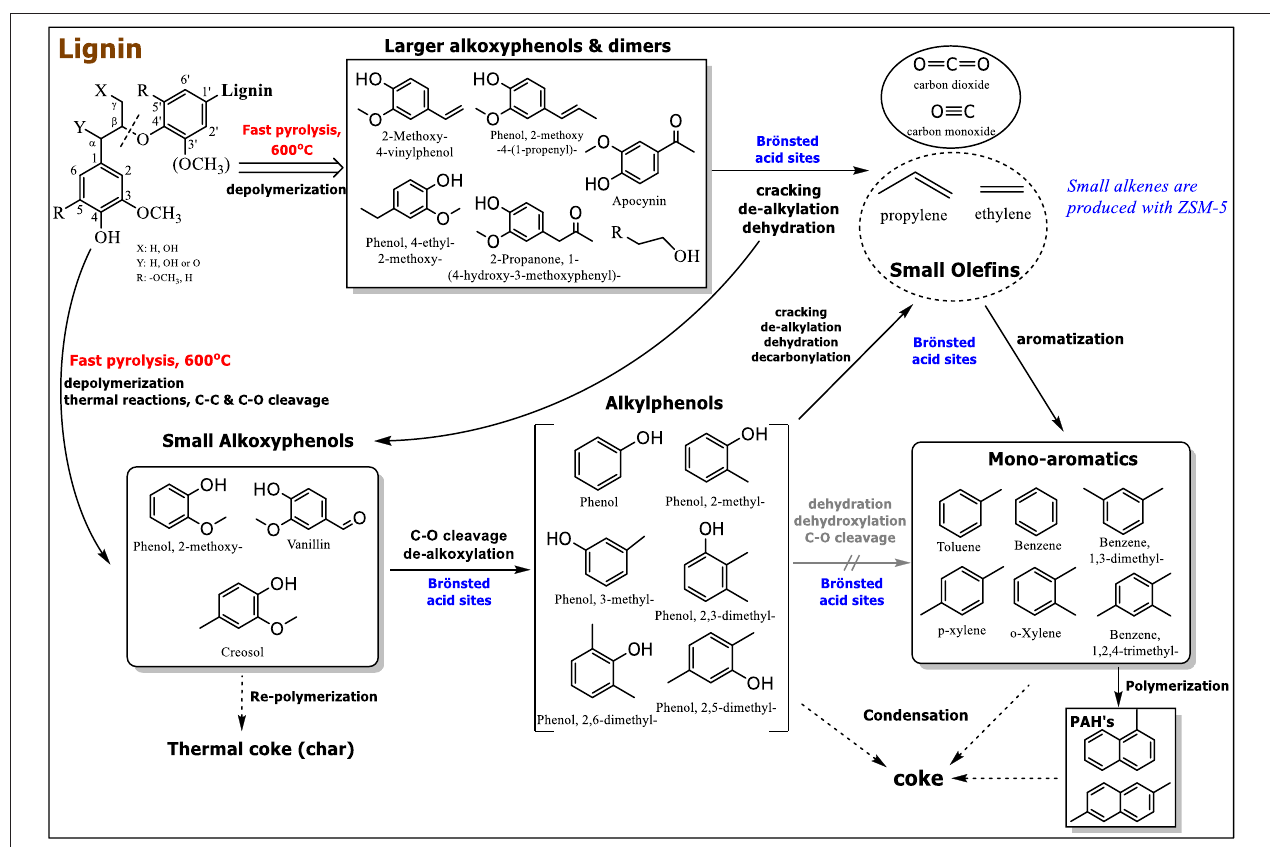
FIGURE 13 | Possible pathways in non-catalytic and catalytic fast pyrolysis of kraft (softwood) lignin by the use of conventional microporous, mesoporous and nano-sized ZSM-5 zeolite.